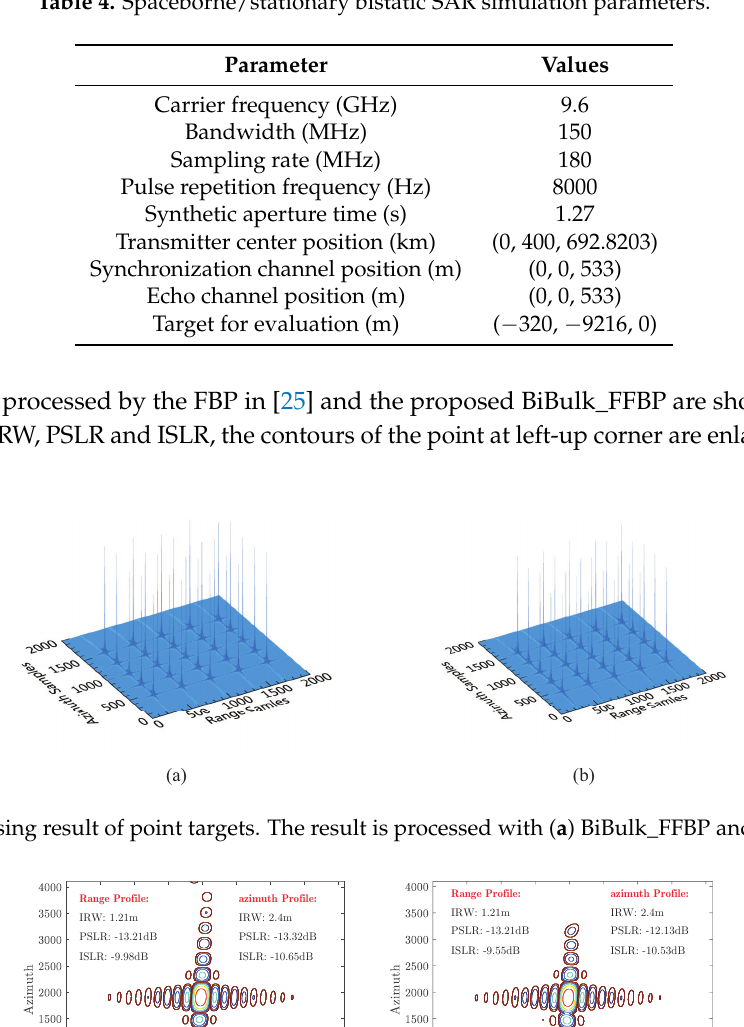
Table 4. Spaceborne/stationary bistatic SAR simulation parameters.